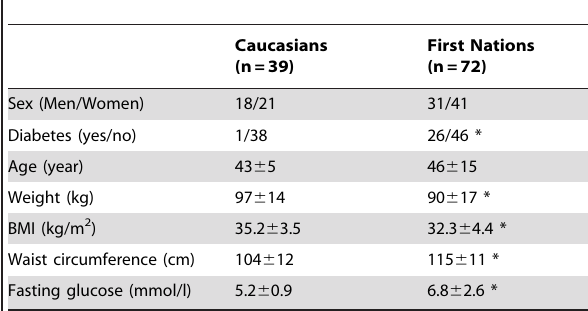
Table 1. Characteristics of